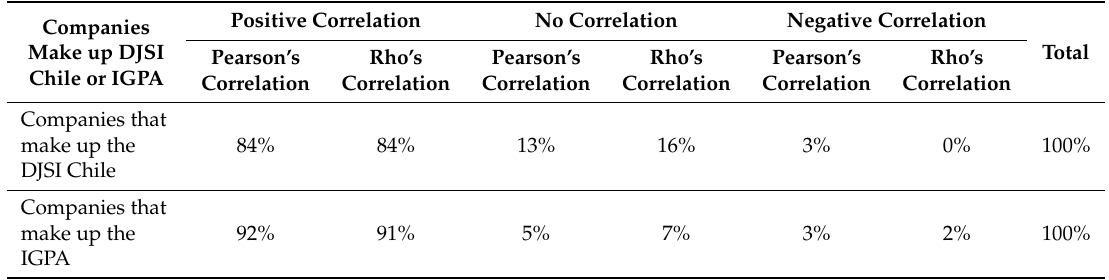
Table 4. Summary of market value correlation with the DJSI Chile.